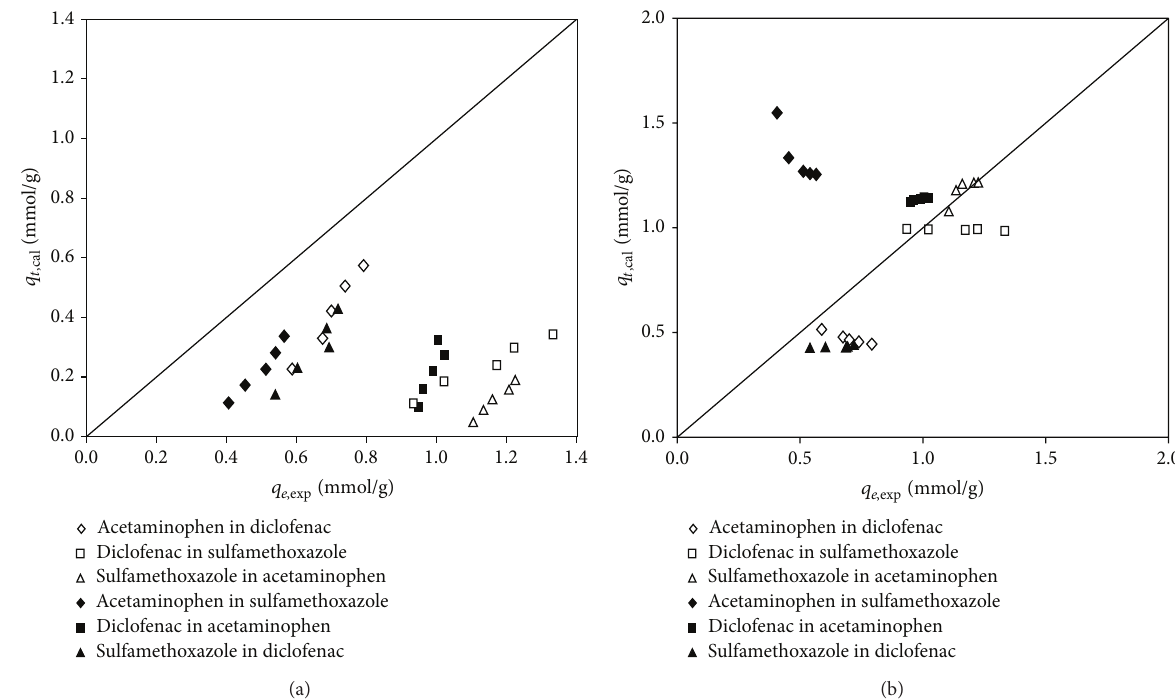
Figure 4: Comparison of the experimental and calculated data according to (a) noncompetitive adsorption and (b) competitive adsorption in binary